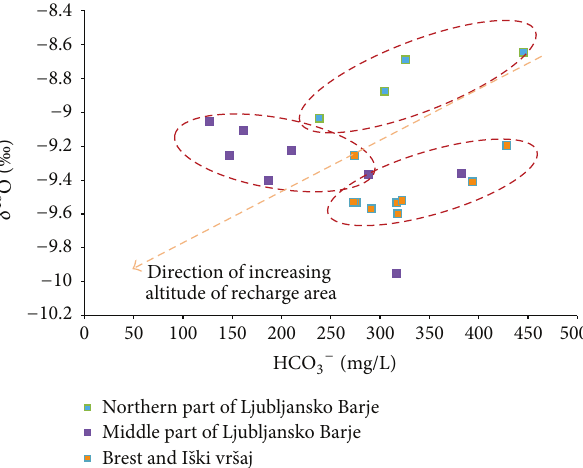
Figure 9: Interpretation of relationship between HCO 3− and iso- topic composition of oxygen ( 𝛿 18 O) in groundwater of Ljubljansko polje and Ljubljansko Barje